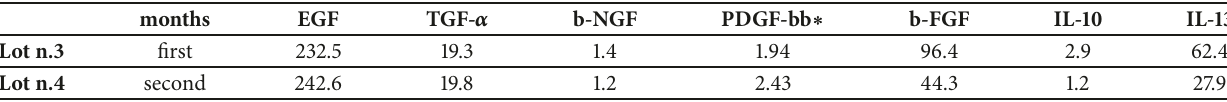
Table 2: Levels of growth factors contained in the CBS eye drops administered to patient n.2, for the first and second month of treatment, respectively. EGF: epidermal growth factor; TGF- 𝛼 : transforming growth factor; b-NGF: basic neural growth factor; PDGF-bb: Platelet- derived growth factor; b-FGF: basic fibroblast growth factor; and IL: interleukin.